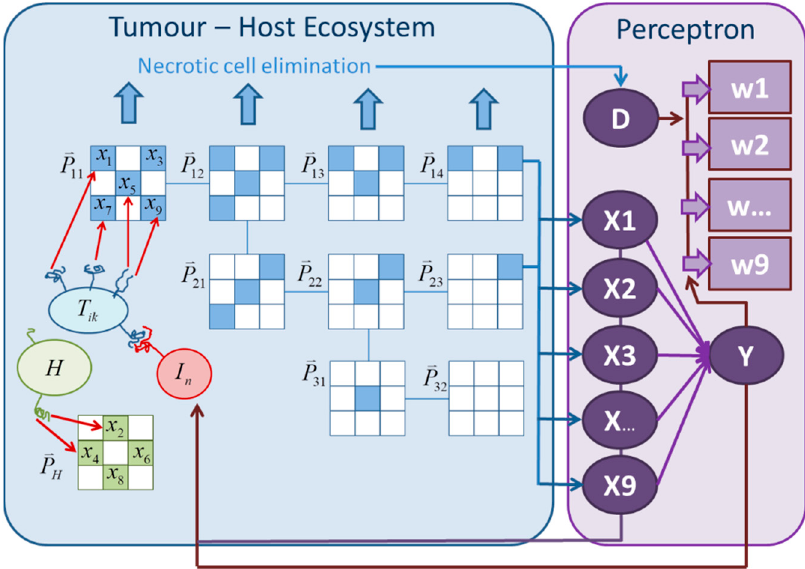
Figure 1. Structure of the tumor–immune system model and mutation tree/tumor sub ‐ clones with associated antigen pattern vectors P ik . Vector components may represent epitopes on a specific complex protein or may be distributed over different proteins. According to the presence antigen vector components, an antigen signal X n together with the danger signal D generate a perceptron response Y which induces the growth and immigration of effector cells ( I n